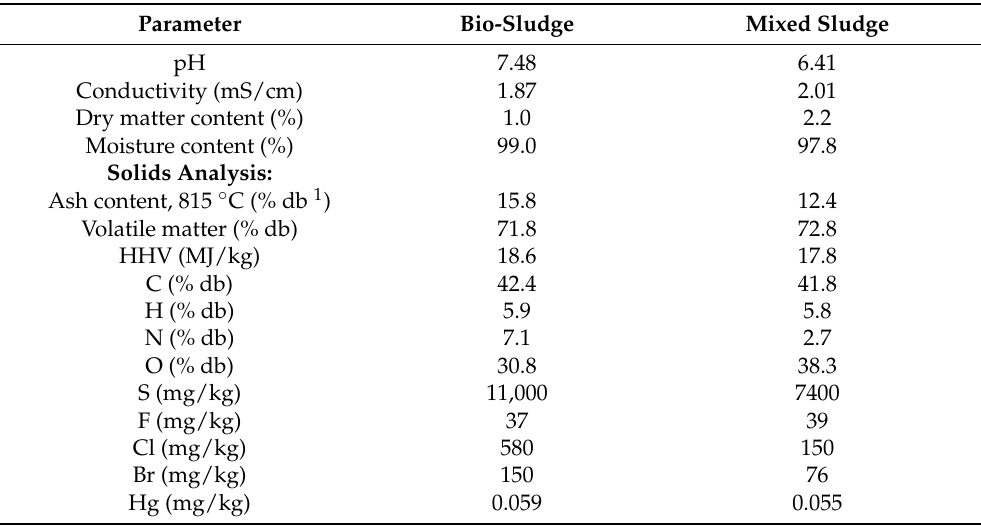
Table 1. Characteristics of biological sludge and mixed sludge (33% biological sludge and 67% fiber sludge) as received. 1 db = dry basis; analysis on solids that were dried at 105 ◦ C.